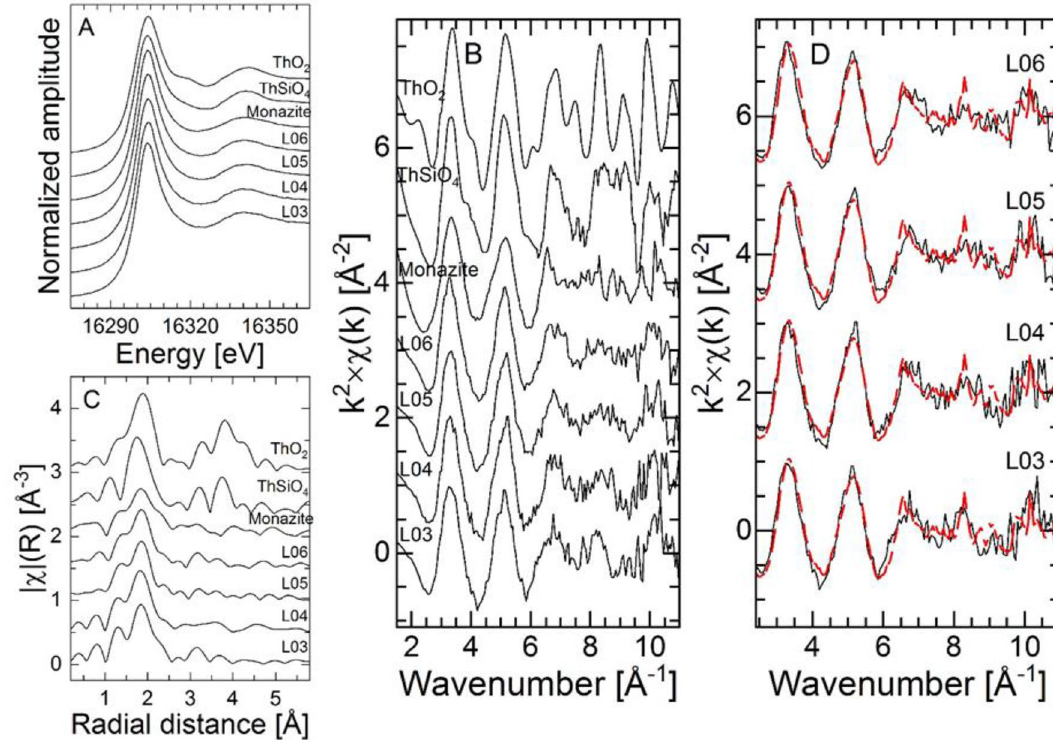
Figure 1. Th L 3 -edge XANES ( A ) and EXAFS spectra ( B ) with corresponding FT ( C ) of all samples and RCs (distance is uncorrected for phase shift); ( D ) experimental (solid black line) and linear combination fits (red dashed line) to the EXAFS spectra of the soil samples (fit results are shown in Table